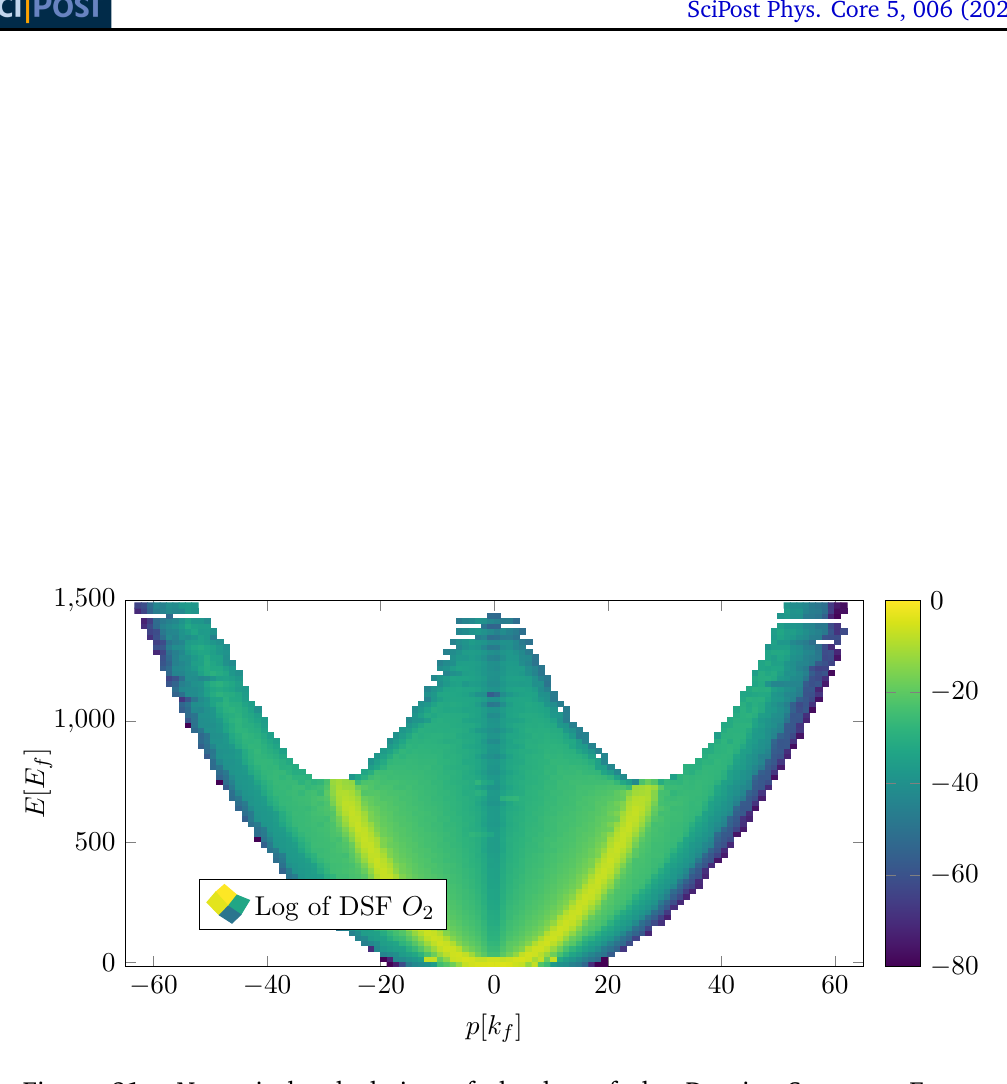
Figure 21: Numerical calculation of the log of the Density Structure Factor O : = 〈 Ψ † ΨΨ † Ψ 〉 via the algorithm, as a function of the momentum and energy of 2 the contributing states, in units of k and E . The color corresponds to the log of F F the weight density in each rectangular bin. T = 6, as temperature rises, the figure stretches to higher E and p , but remains qualitatively similar. N = L = 15. The heat map shown is a flat average, bin-wise, over that of 50 sampled states, before taking the